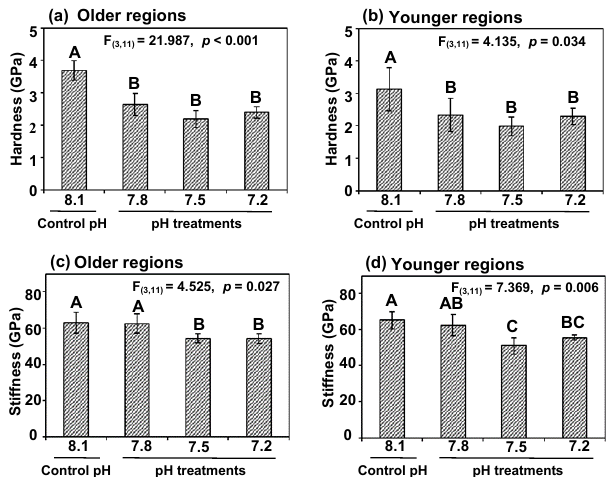
Figure 5. Shell mechanical properties in terms of hardness (a, b) and stiffness (c, d) with longer and shorter exposures in older hinge regions (a, c) and younger middle regions (b, d) in cross-sectional shell surfaces of Magallana angulata were compared. Data of me- chanical properties are presented as mean ± SD of three to four replicates ( n = 3 or